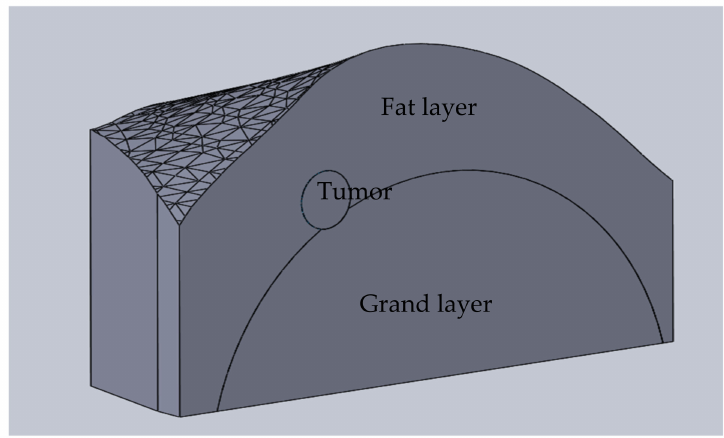
Figure 15. A 3D model with computed parameters (Patient No.